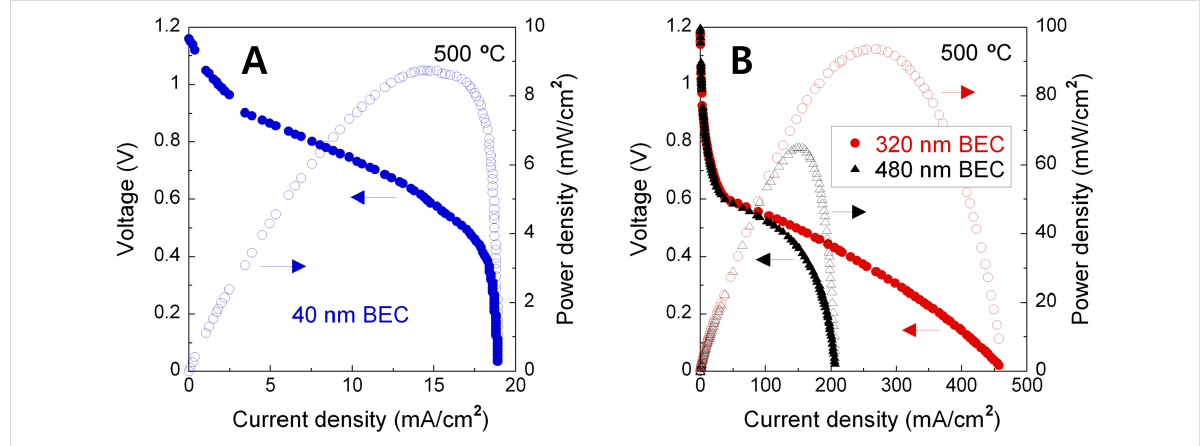
Figure 1: I – V and power density curves, measured at 500 °C, for 80 nm pore AAO supporting (A) 40, (B) 320 and 480 nm-thick bottom electrode catalyst (BEC, sputtered Pt anode deposited under high-vacuum) solid oxide fuel cells, referred to the Cell-A, Cell-B and Cell-C, having 210 nm-thick atomic layer-deposited (ALD) yttria-stabilized zirconia (YSZ) electrolyte and 60 nm-thick top electrode catalyst (sputtered porous Pt